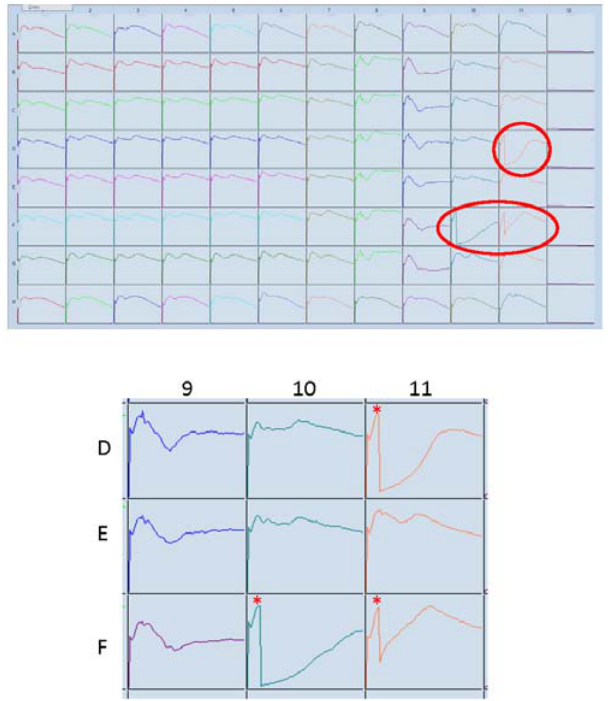
Figure 9. xCELLigence SP “Well Graph” view for drug discovery. An additional